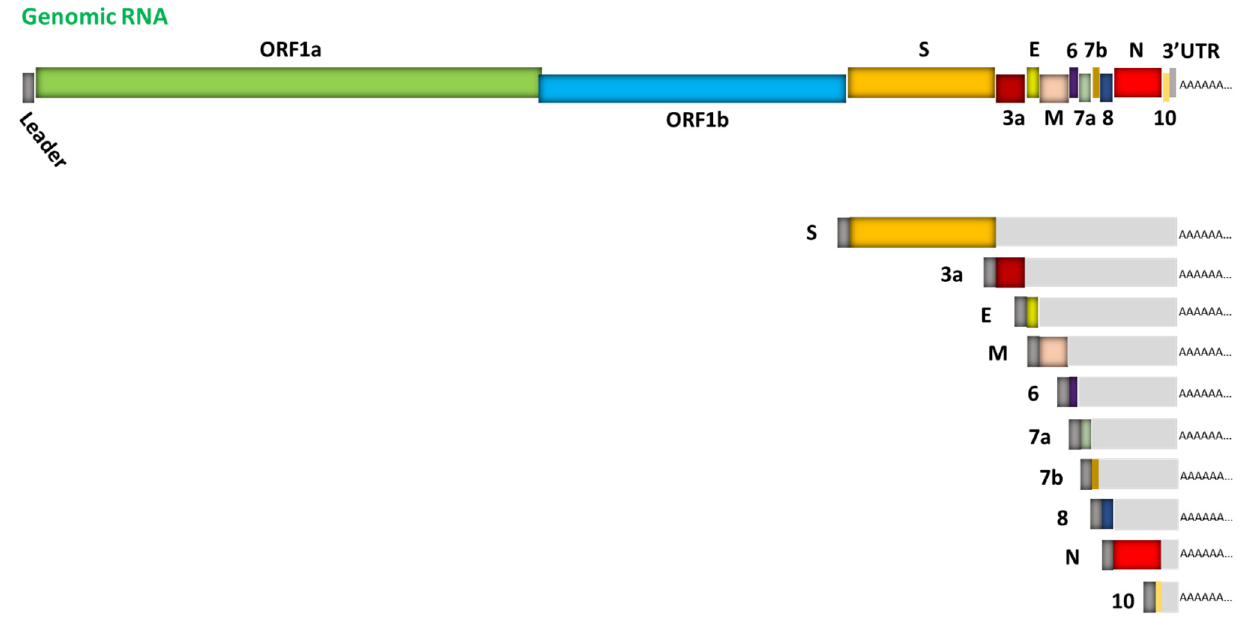
Figure 1. Schematic representation of SARS-CoV-2 genome organization and the canonical subgenomic mRNAs. The genome features two large genes, ORF1a and ORF1b, which encode a total of 16 non-structural proteins (nsp1-nsp16) (primary translation); structural genes encoding structural proteins include spike (S), envelope (E), membrane (M), and nucleocapsid (N), respectively; and genes encoding several small accessory proteins (3a, 6, 7a, 7b, 8 and 10). Depicted in the lower right are 10 canonical subgenomic mRNAs. Figure is adapted from [12].